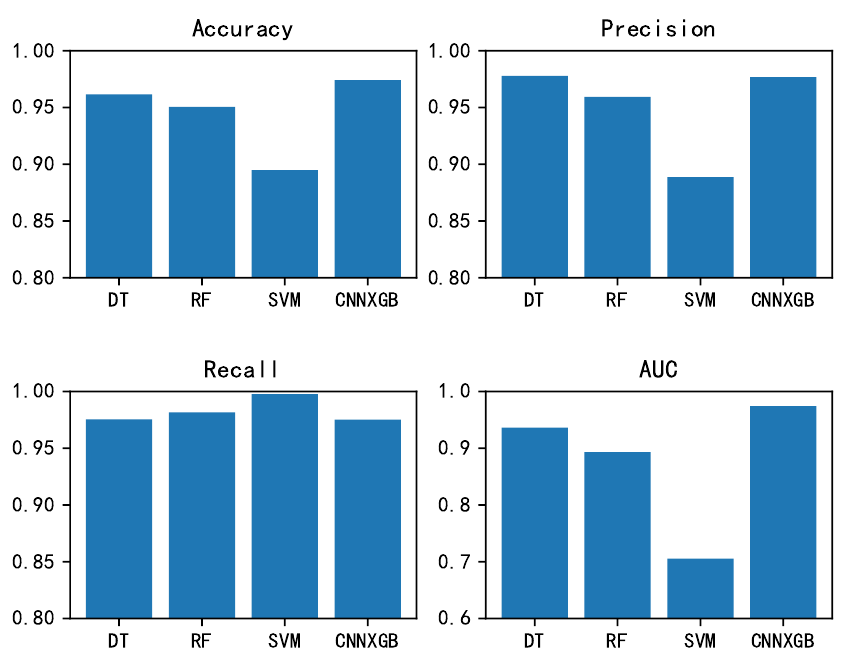
Figure 13. Detection result comparison of CNNXGB and other